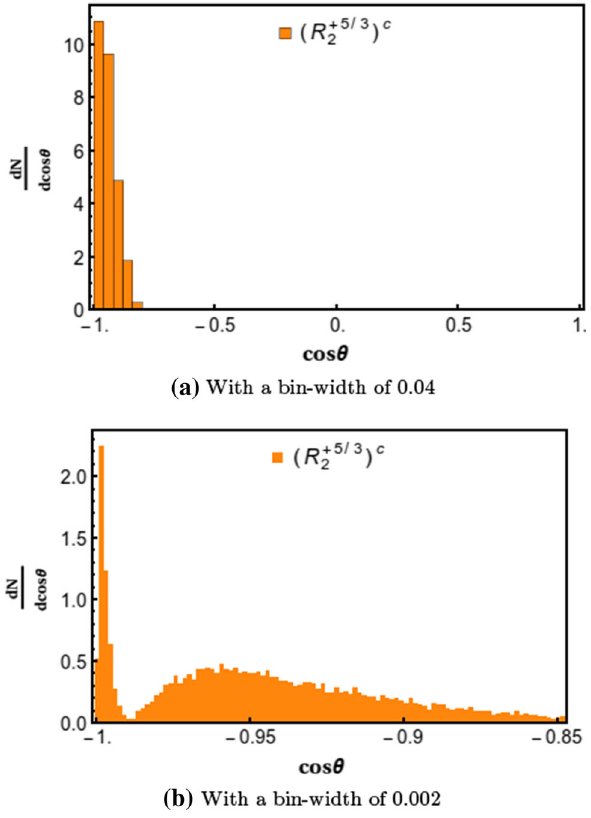
Table 6. Significances with L int = 100 fb − 1 and 400 pb −